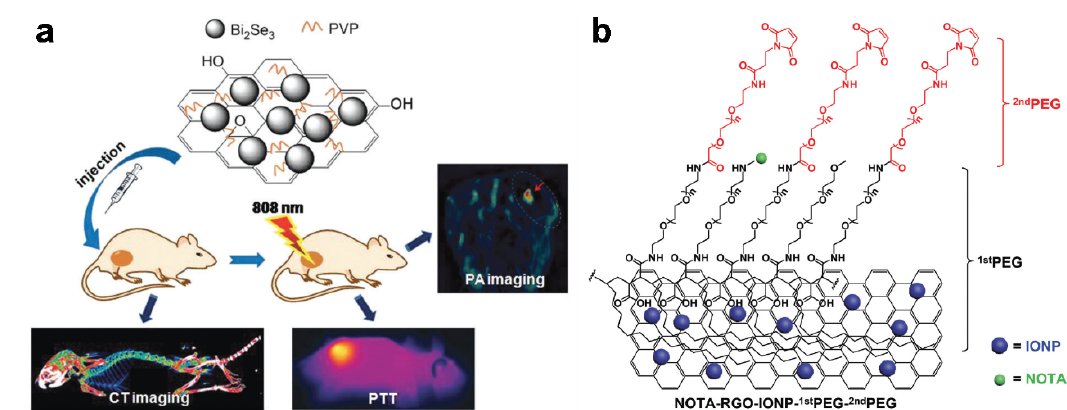
Figure 12. ( a ) Schematic diagram of GO/Bi 2 Se 3 /PVP nanocomposites for CT/PA imaging and PTT. Reprinted with permission from [86]. Copyright, The Royal Society of Chemistry (2017). ( b ) Schematic illustration of the structure of the NOTA-RGO-IONP- 1st PEG- 2nd PEG nanocomposite. Reprinted with permission from [85]. Copyright, The Royal Society of Chemistry (2016).